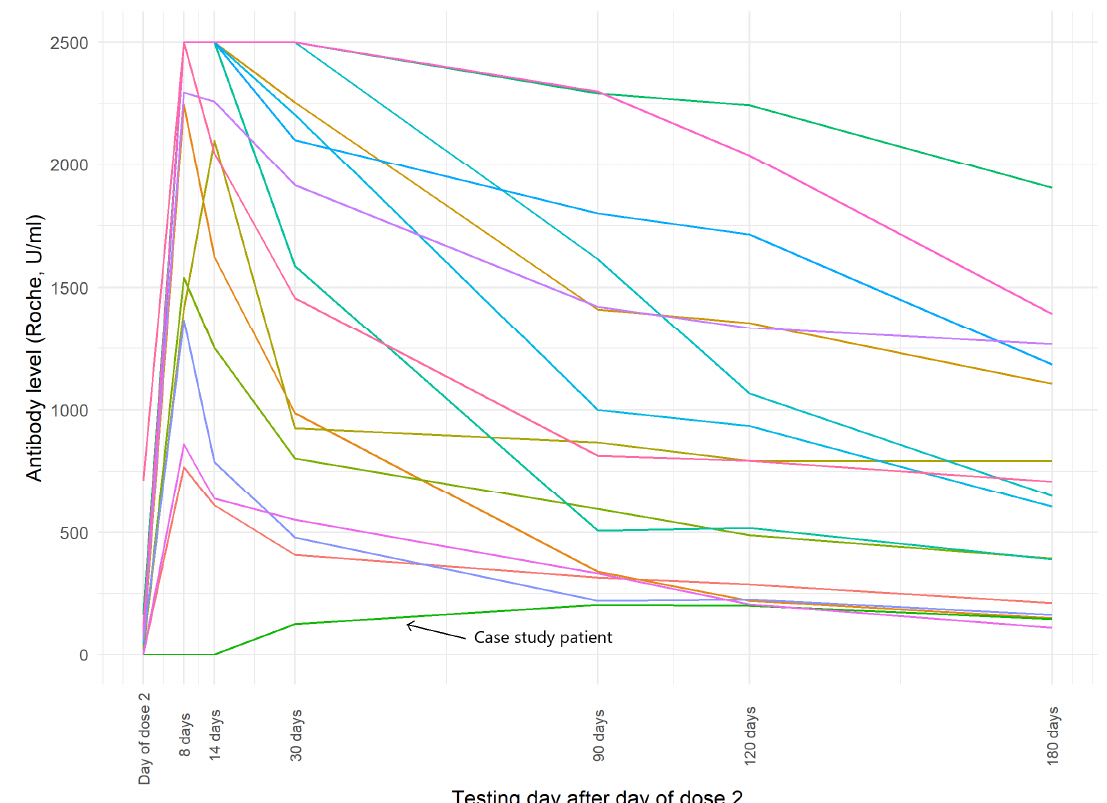
Figure 2. Individual dynamics of change in levels of SARS-CoV-2 antibodies post vaccination in the case study patient and 15 female study participants aged 45–55. Table 1. Roche and DiaSorin test result for samples up to day 30 after dose